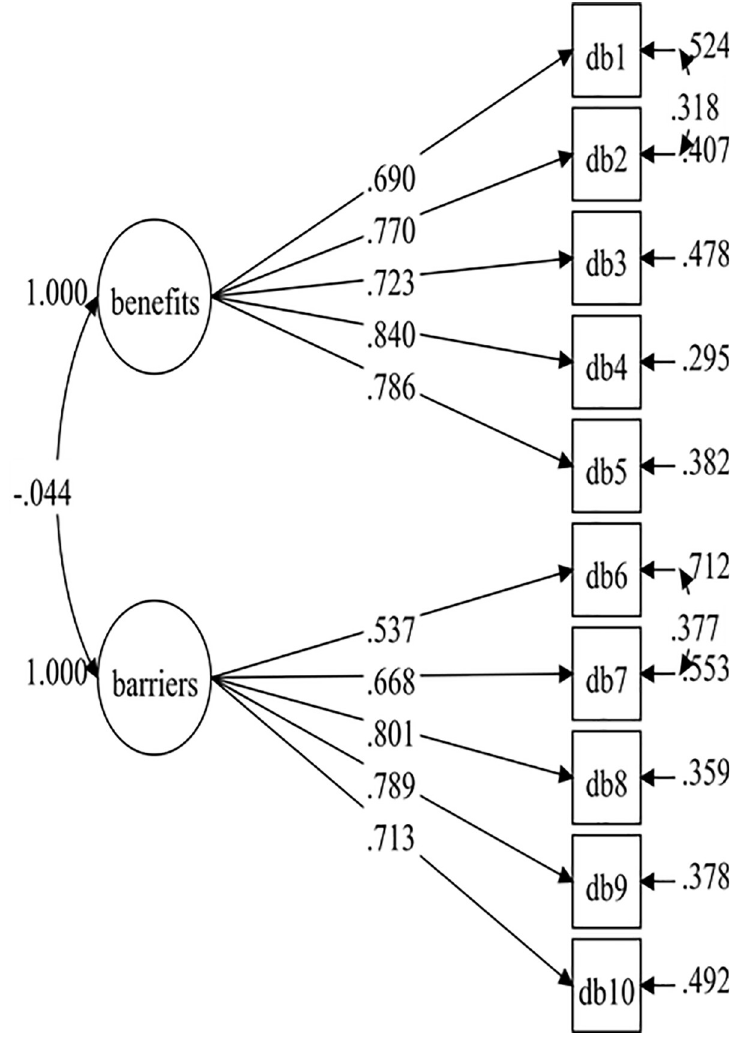
Fig 3. Male DB-M model